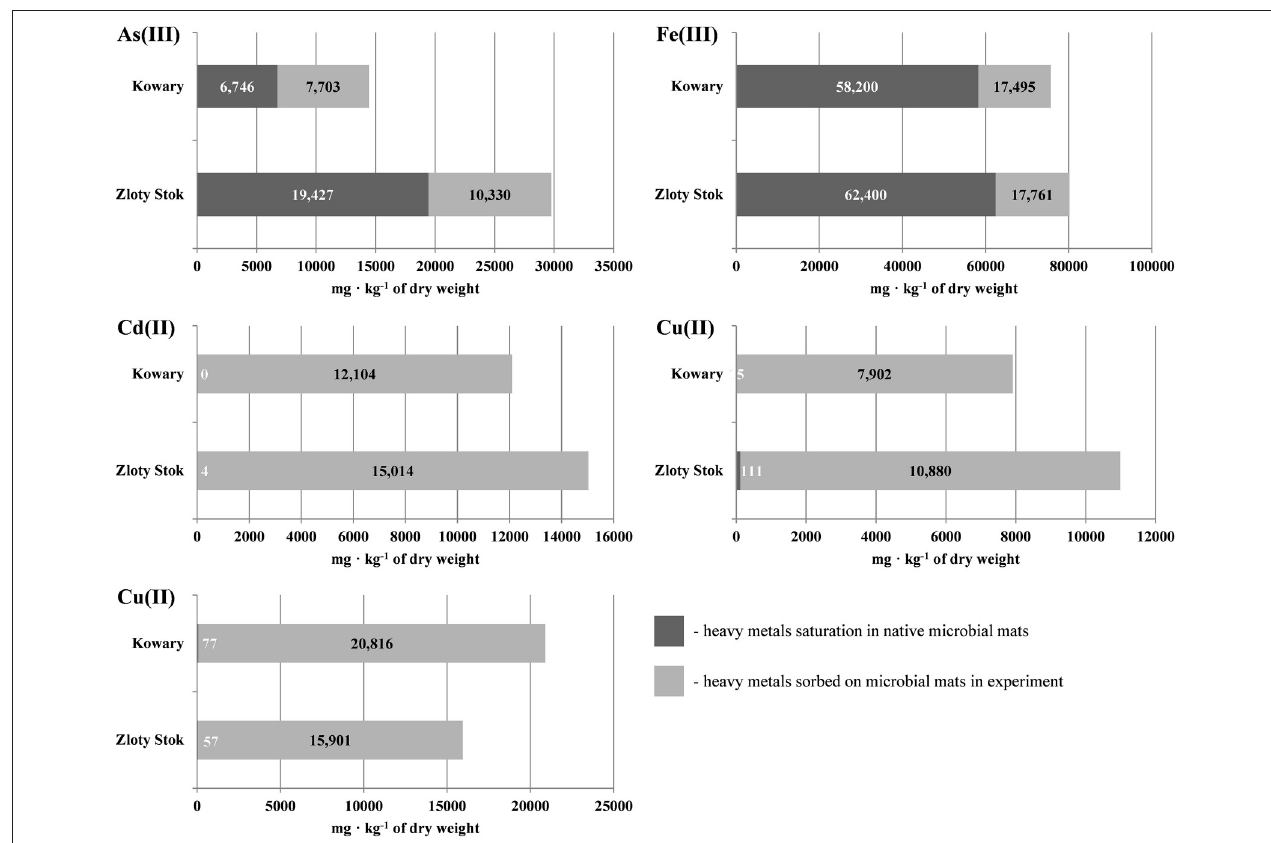
FIGURE 2 | Sorption capacity of microbial mats from KOW and ZS for As(III), Cd(II), Co(II), Cu(II), and